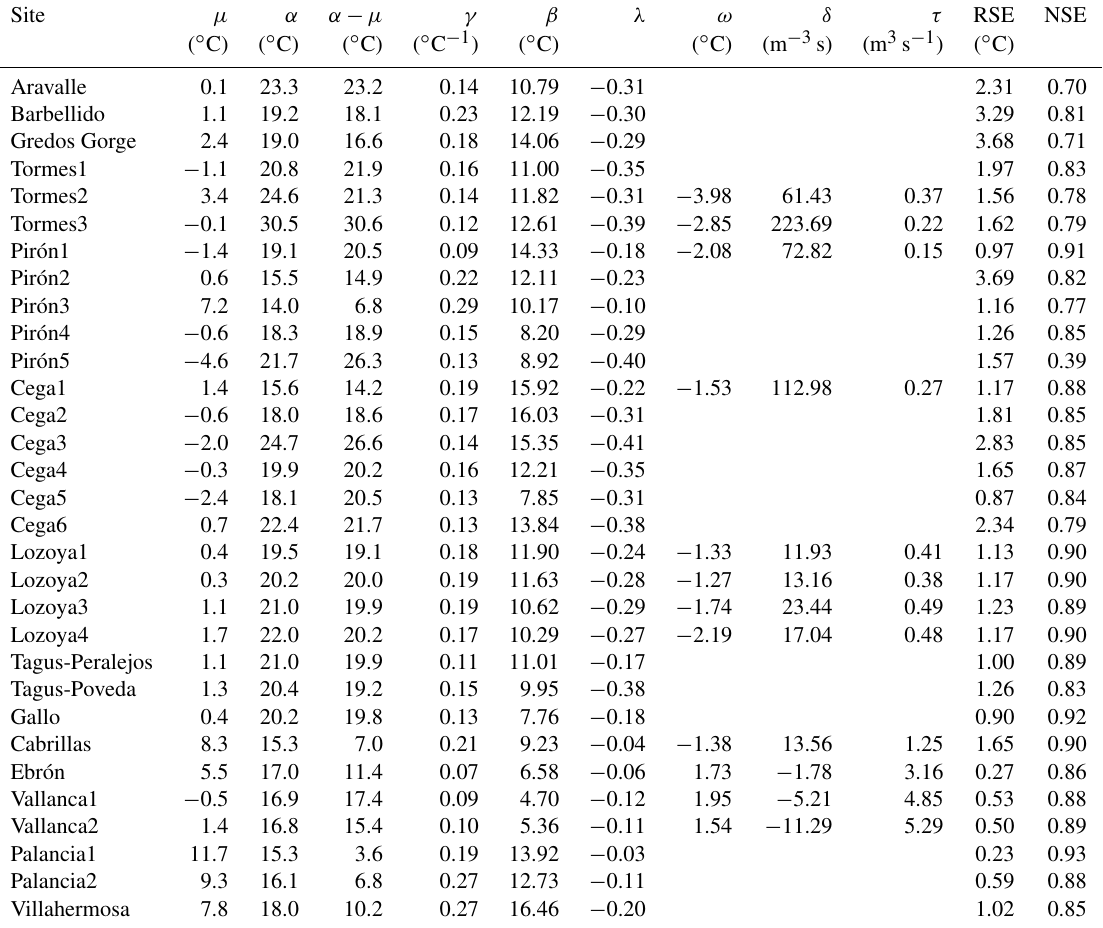
Table 6. Parameter values of the stream temperature models for every thermograph site ( λ is a dimensionless parameter) and values of the performance indicators residual standard error (RSE) and Nash–Sutcliffe efficiency index